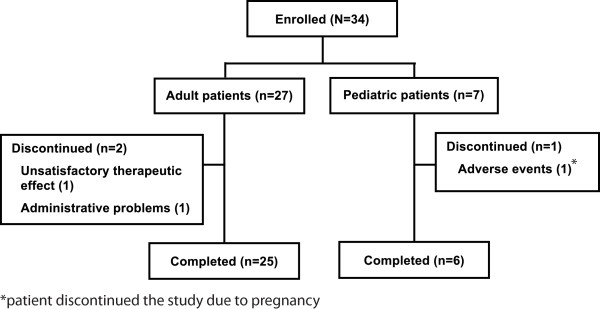
Patient composition.